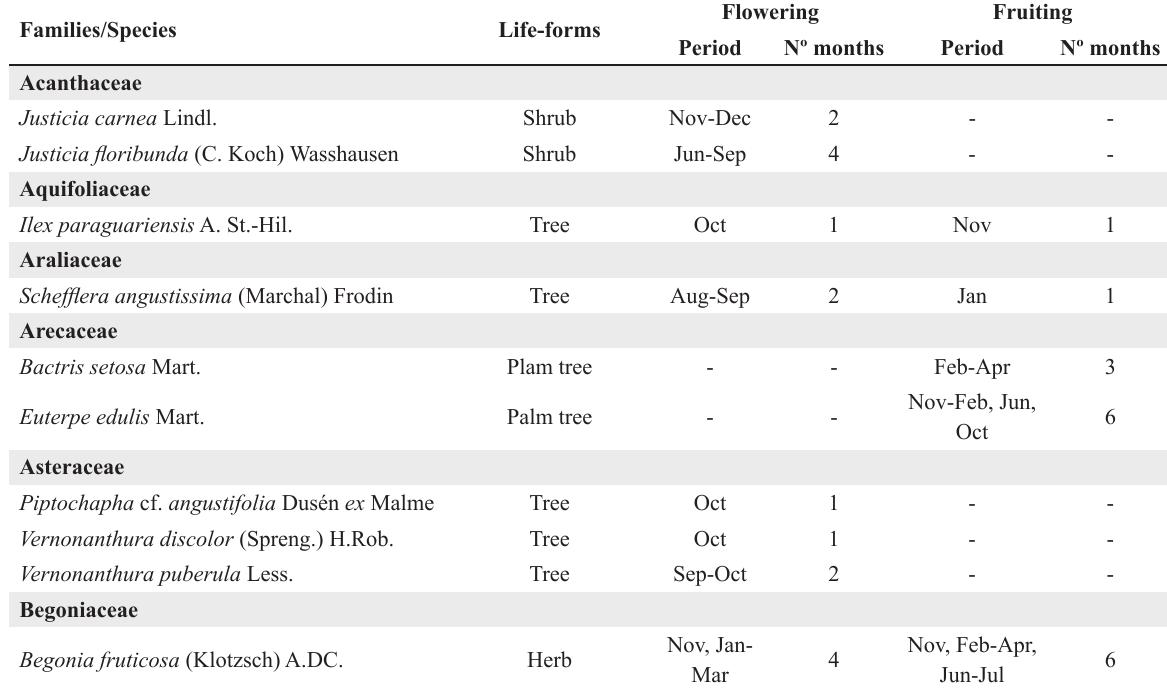
Reproductive phenophases behavior, life-form, and period of phenophases occurrence of each species observed during the study